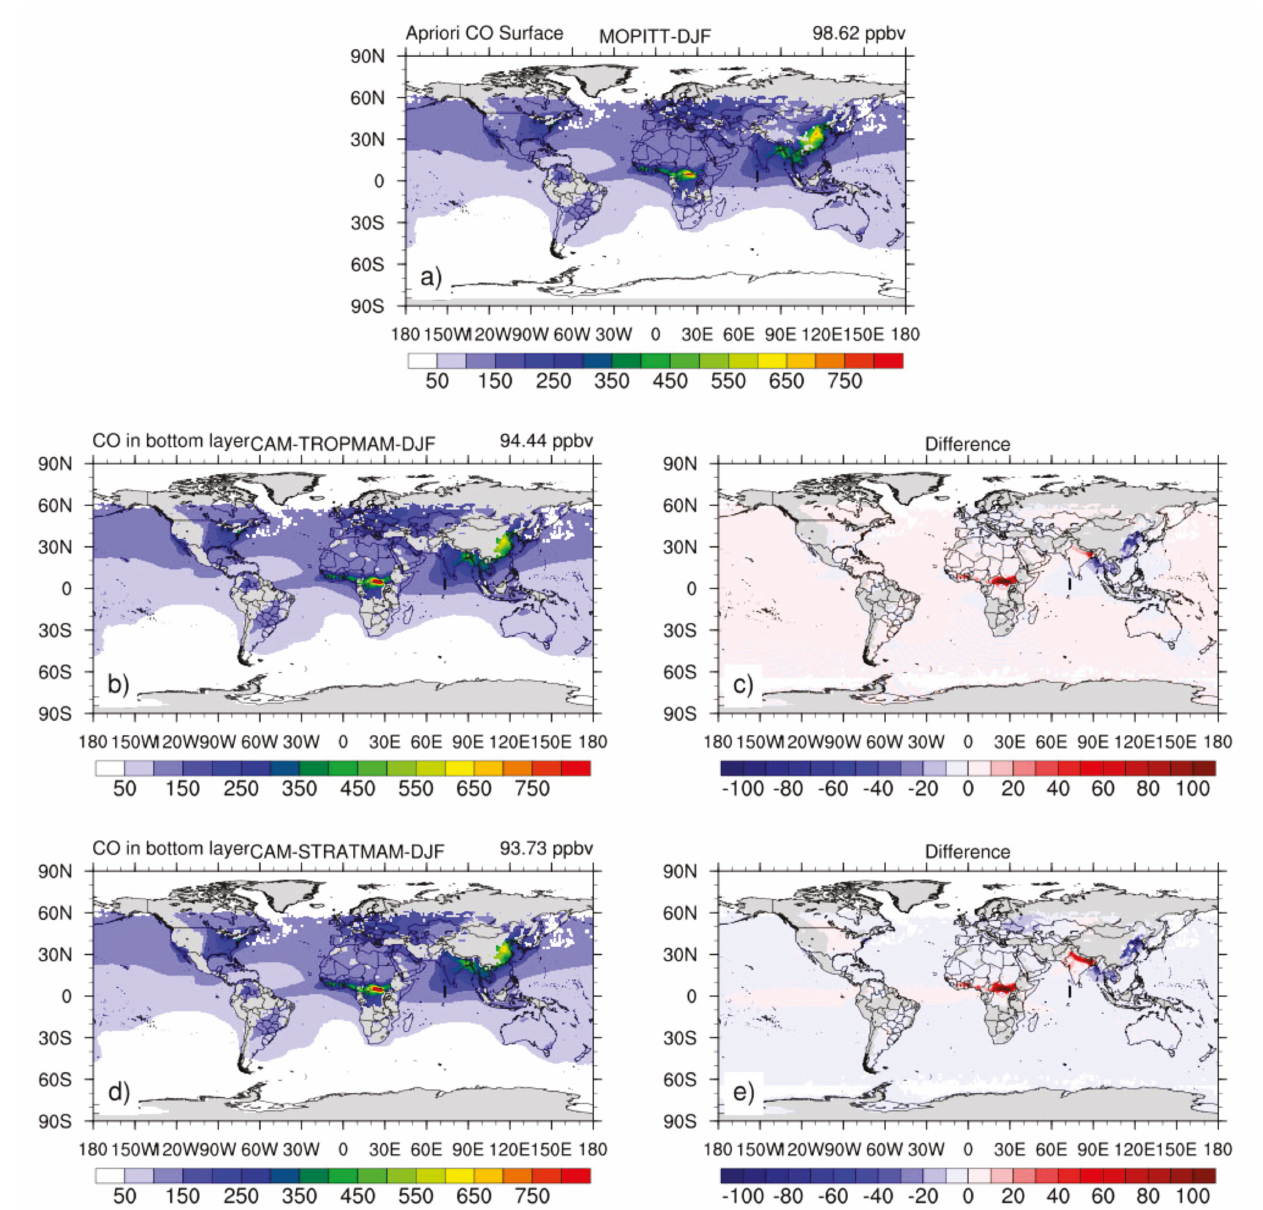
Figure 1. ( a ) CO (ppb) observed by MOPITT sensor for December-January-February (DJF), in the period of 2010–2014, ( b ) CO simulated by the CAM5-MAM3 model using tropospheric chemistry and ( d ) tropospheric/stratospheric chemistry mechanisms using the calculations of Equation (4). The right side of the figure shows the model difference minus the observation (MOPITT), ( c ) for tropospheric chemistry and ( e ) for tropospheric/stratospheric